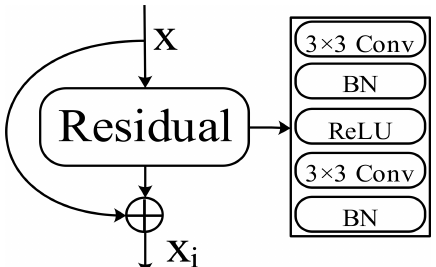
Figure 5. Residual connection. Each residual block is composed of convolutions (Conv), batch normalizations (BN), and rectified linear units